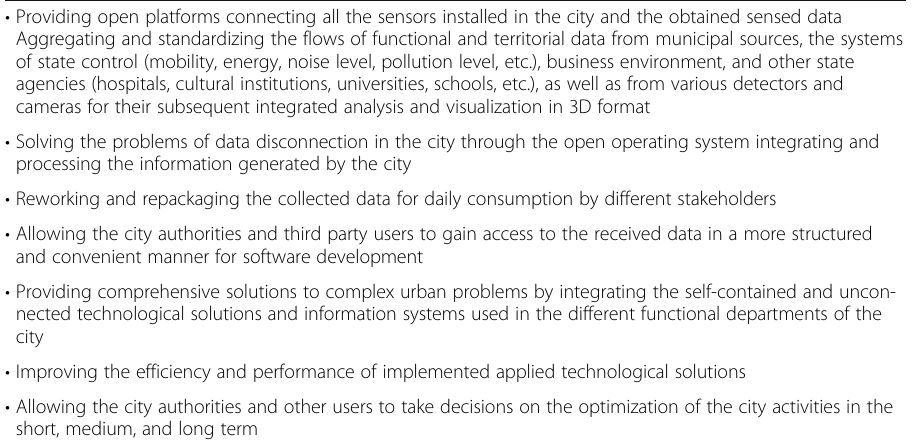
Table 8 The key functions of horizontal information systems (cid:129) Providing open platforms connecting all the sensors installed in the city and the obtained sensed data Aggregating and standardizing the flows of functional and territorial data from municipal sources, the systems of state control (mobility, energy, noise level, pollution level, etc.), business environment, and other state agencies (hospitals, cultural institutions, universities, schools, etc.), as well as from various detectors and cameras for their subsequent integrated analysis and visualization in 3D format (cid:129) Solving the problems of data disconnection in the city through the open operating system integrating and processing the information generated by the city (cid:129) Reworking and repackaging the collected data for daily consumption by different stakeholders (cid:129) Allowing the city authorities and third party users to gain access to the received data in a more structured and convenient manner for software development (cid:129) Providing comprehensive solutions to complex urban problems by integrating the self-contained and uncon- nected technological solutions and information systems used in the different functional departments of the city (cid:129) Improving the efficiency and performance of implemented applied technological solutions (cid:129) Allowing the city authorities and other users to take decisions on the optimization of the city activities in the short, medium, and long